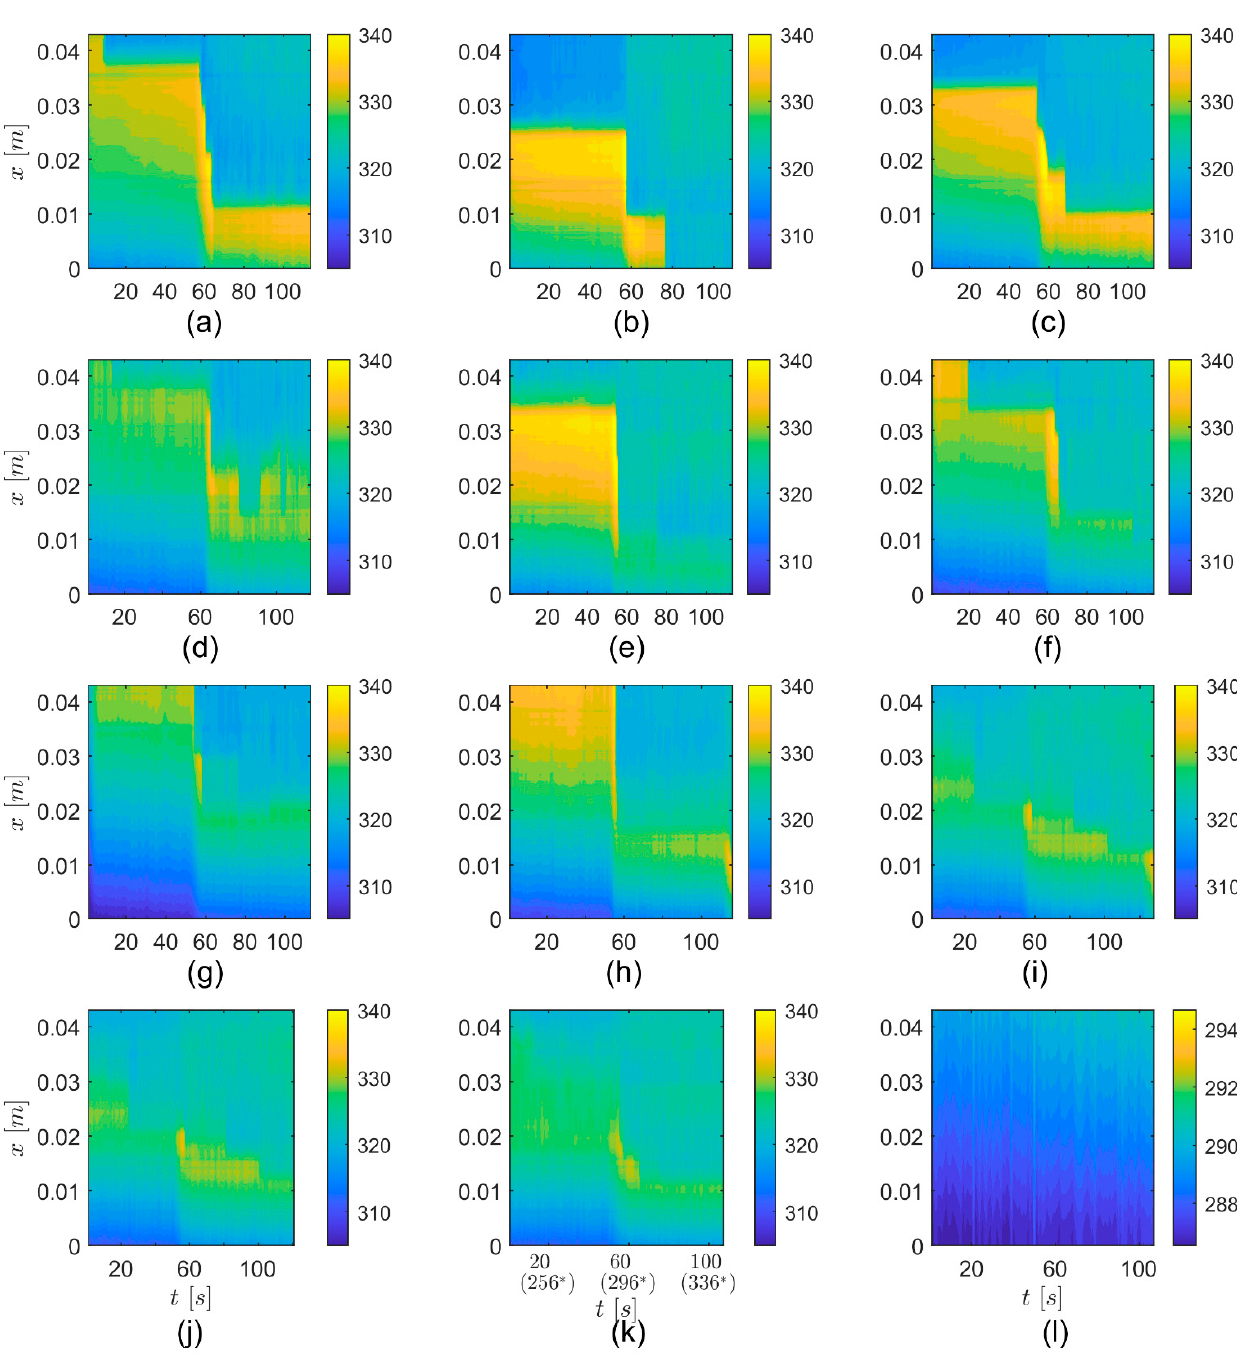
Figure 9. The distribution of the heater temperature versus coordinate x and time, based on infrared thermography measurement, performed on the outer foil surface, mass flow rate: ( a ) Q m = 5 [ kg/h ] ; ( b ) Q m = 10 [ kg/h ] ; ( c ) Q m = 15 [ kg/h ] ; ( d ) Q m = 20 [ kg/h ] ; ( e ) Q m = 25 [ kg/h ] ; ( f ) Q m = 30 [ kg/h ] ; ( g ) Q m = 35 [ kg/h ] ; ( h ) Q m = 40 [ kg/h ] ; ( i ) Q m = 45 [ kg/h ] ; ( j ) Q m = 50 [ kg/h ] ; ( k ) Q m = 55 [ kg/h ] , *–the numbering of moments of time related to the entire experiment (see Figure 4l); ( l ) the fluid temperature at the reference line (see Figure 2), Q m = 55 [ kg/h ] , calculations according to ADINA software.